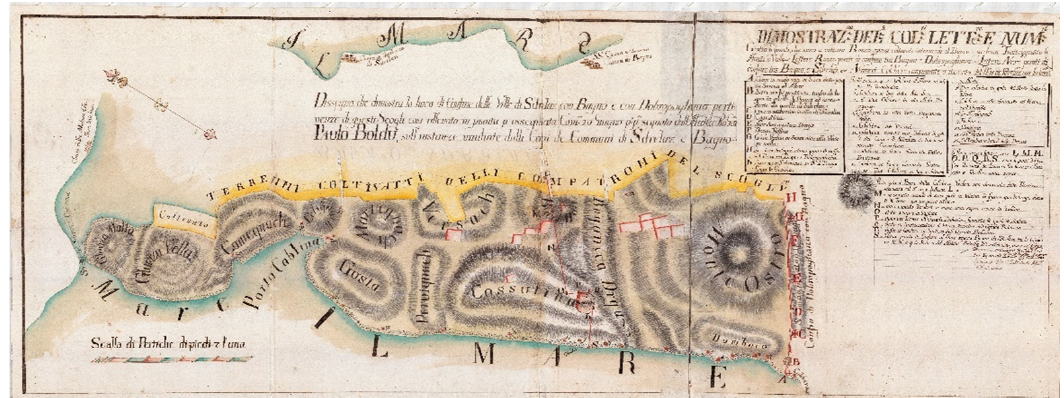
Figure 9. Licini Rub č i ć ’s map of the north-western part of the island of Pašman with depiction of lime kilns, 1782. The mapmaker marked each lime kiln with a circle and an identifying number.